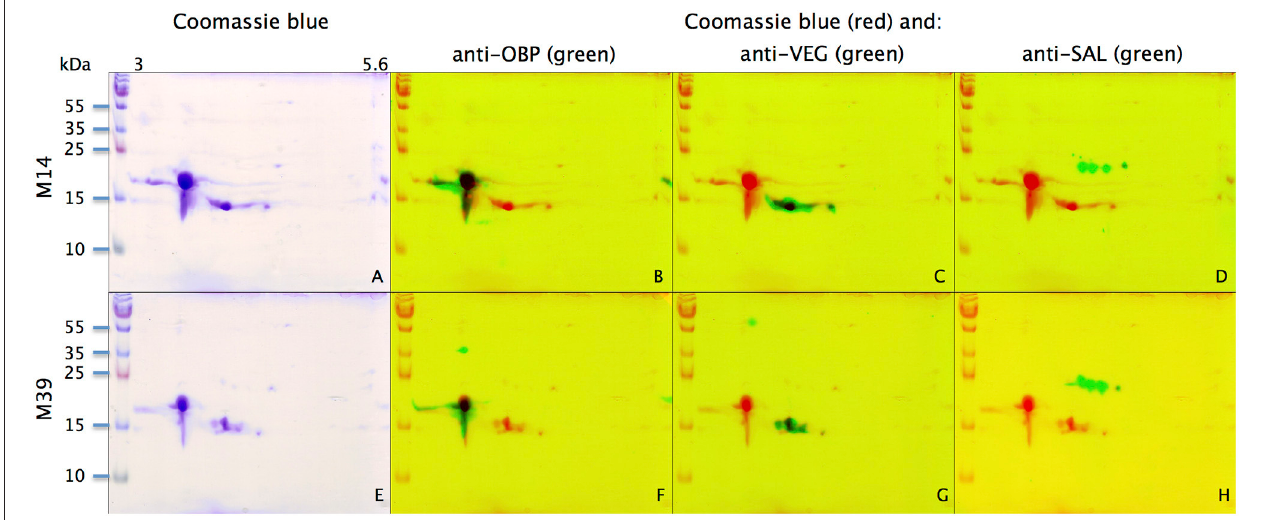
FIGURE 2 | Identification of OBP, VEG, and SAL with specific antibodies in M14 (A–D) and M39 (E–H) secretomes. (A,E) Coomassie-blue staining. (B,F) Merge of Coomassie-blue staining (red) and western-blot with anti-OBP (green). (C,G) Merge of Coomassie-blue staining (red) and western-blot with anti-VEG (green). (D,H) Merge of Coomassie-blue staining (red) and western-blot with anti-SAL (green). X-axis: pI, Y-axis: molecular weight.